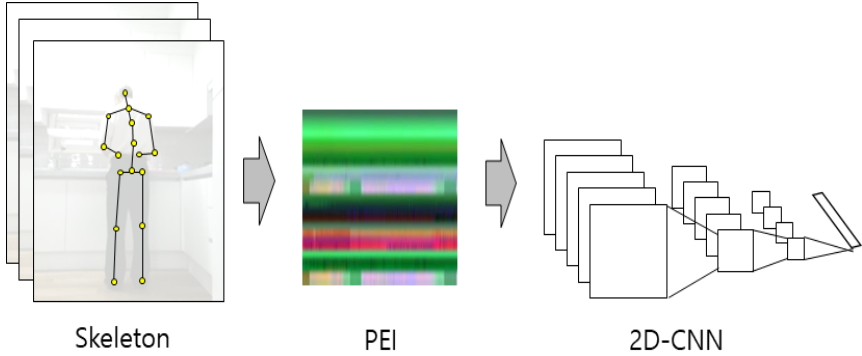
Figure 8. Schematic diagram of the 2D-CNN of the PEI input.